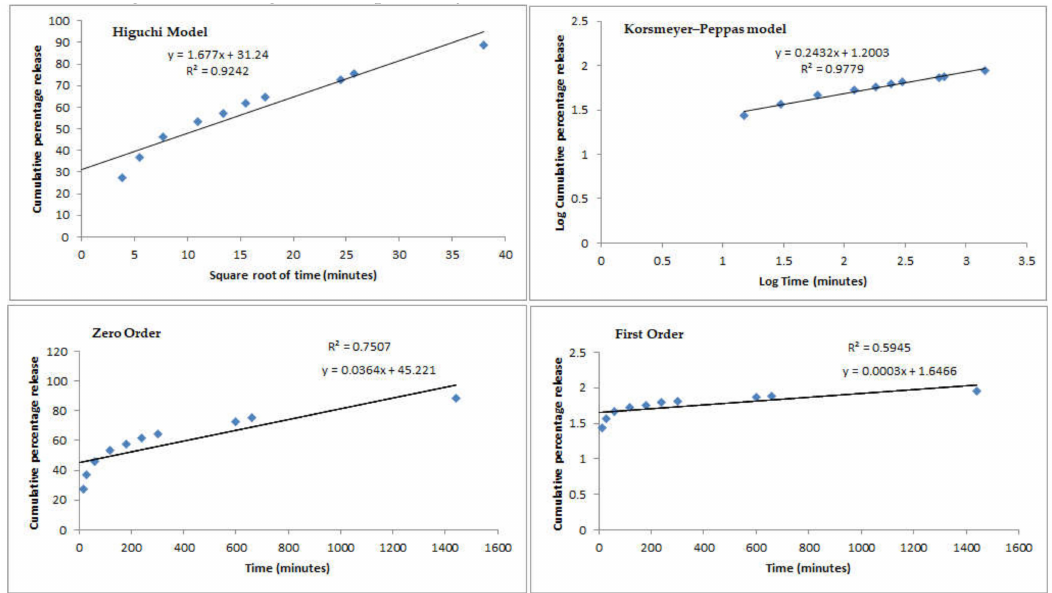
Figure 2. Mathematical fitting models (Higuchi model, Korsmeyer–Peppas model, zero order, and first order) of the cumulative percentage of EGCG release from non-coated microspheres (Ch-PP60 8:1 ) in simulated gastrointestinal